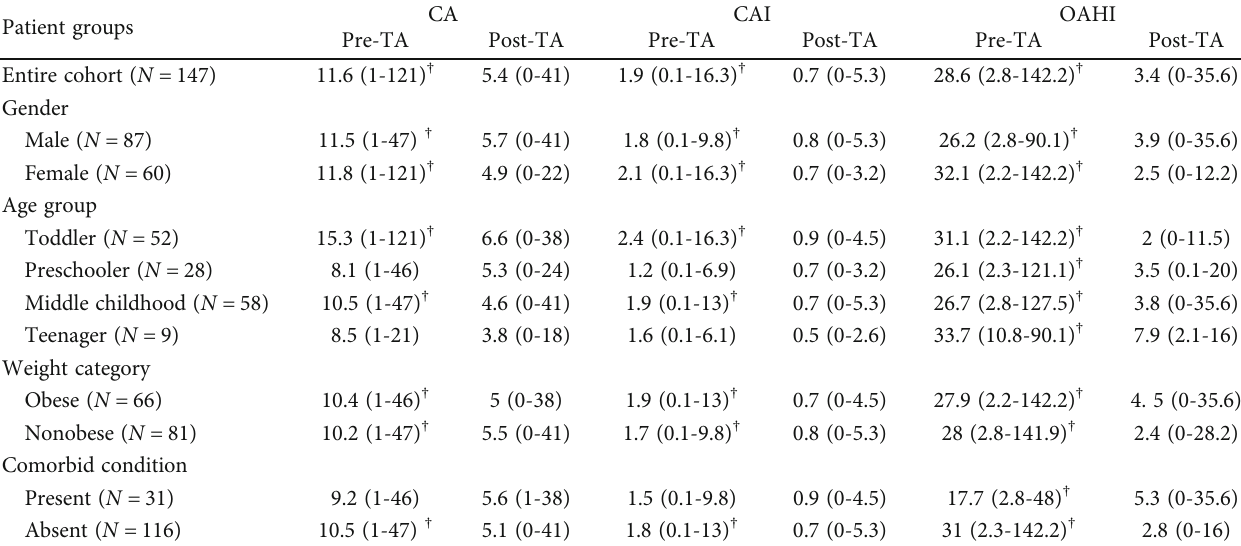
Figure 3: Comparison of central apnea index (CAI) in children with obstructive sleep apnea (OSA). The CAI in patients with severe OSA was higher than that of patients with no OSA, mild OSA, and moderate OSA ( p = 0 : 001 ). Table 2: Comparison of pre- and postoperative polysomnography fi